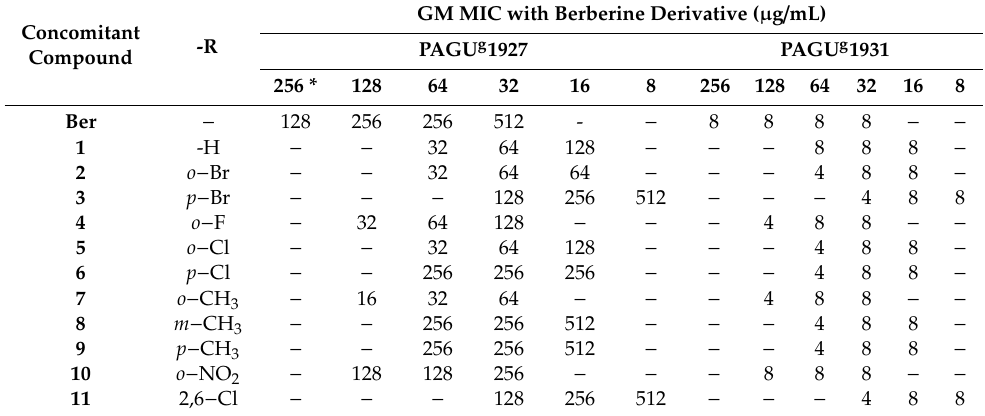
Table 2. Increase in sensitivity to gentamicin by combination with berberine derivatives. Concomitant